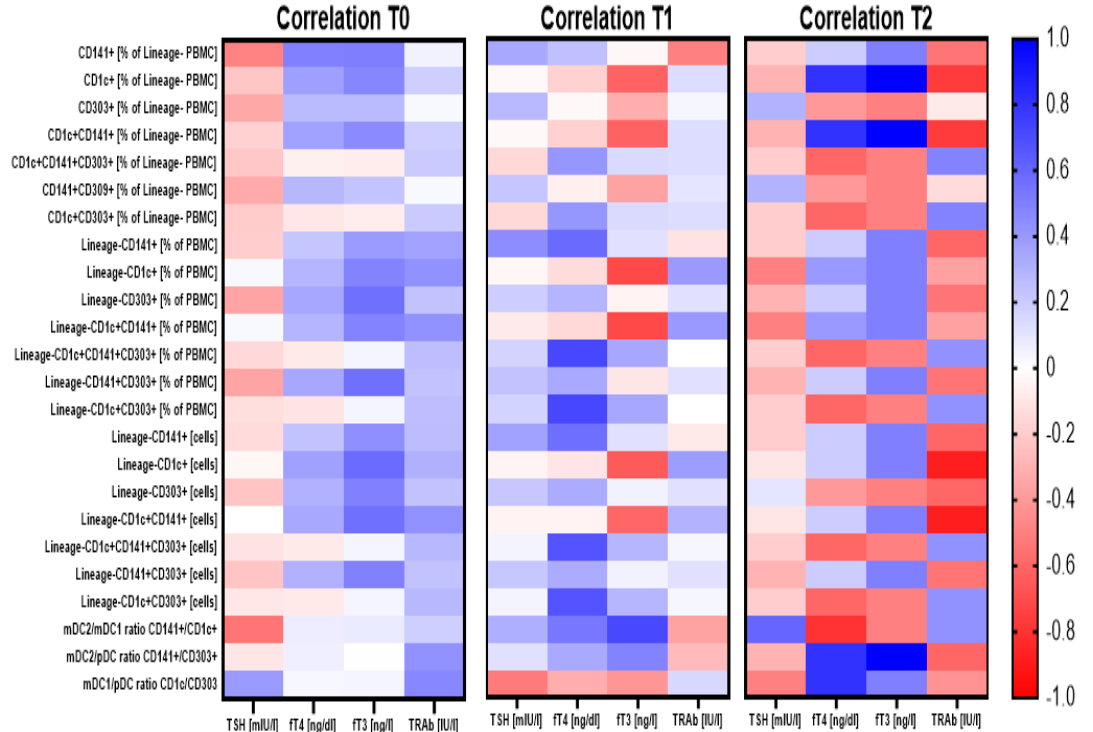
Figure 3. Demonstration of correlations between dendritic cell-related parameters and critical clinical analysis results prior to and during the treatment course. Correlation analysis demonstrated for three time points for Graves’ disease pediatric patients: before treatment (T0) and after 3 months (T1) and 1 year (T2) of the treatment. Strength of correlations (r value) are demonstrated through color gradient—blue for positive correlations and red for negative correlations.